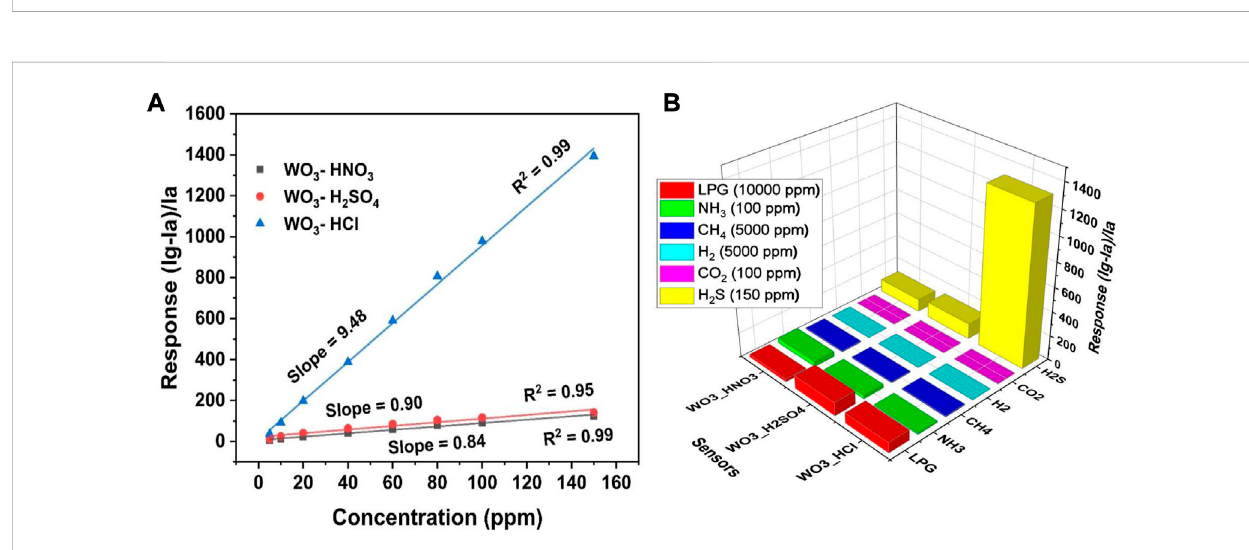
FIGURE 10 (A) Sensors ’ response versus H 2 S concentrations at 125 ° C, showing the sensitivity of WO 3 - based sensors, and (B) 3D selectivity plot of the WO 3 -based sensor towards, LPG, NH 3 , CH 4 , H 2 , CO 2 , H 2 S, at 125 °